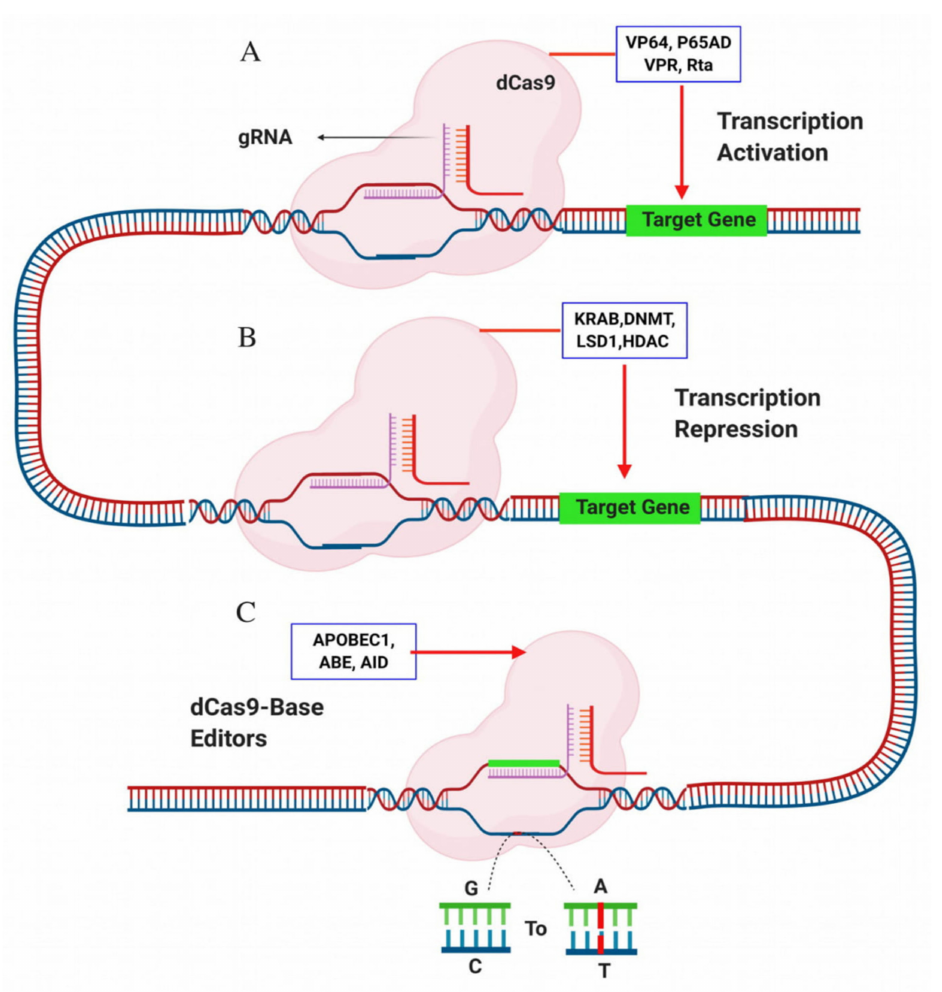
Figure2. DeactivatedCas9(dCas9)usedforgeneactivation, repressionandbaseediting.